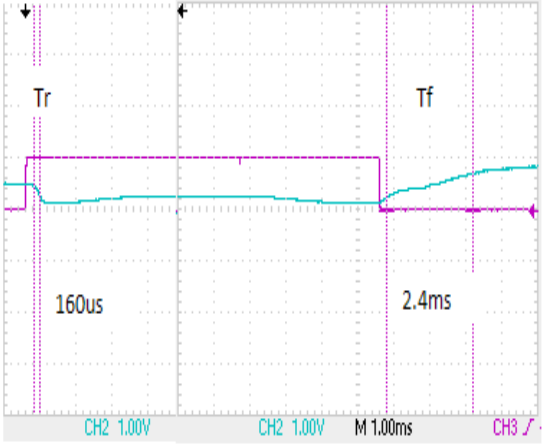
Figure 4. Rising and falling response time of the flexible liquid crystal lens.